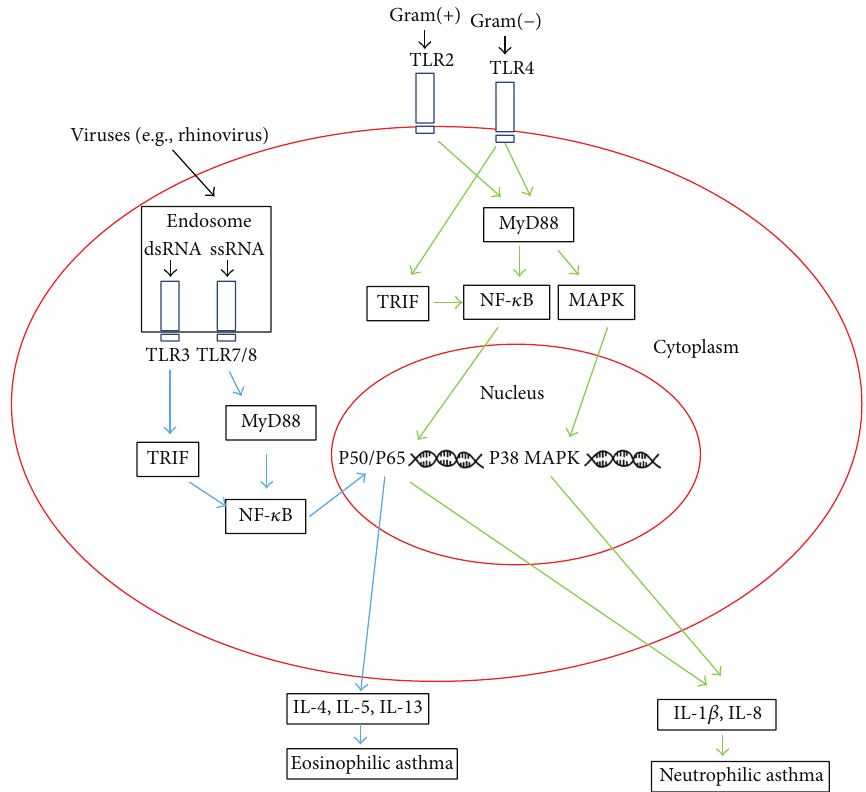
Figure 1: Schematic overview of TLR signaling pathway in neutrophilic and eosinophilic asthma. Gram-negative and Gram-positive bacteria as well as respiratory viruses (e.g., rhinovirus) are detected by TLRs. Subsequently, TLR3 and TLR7/8 trigger TRIF and MyD88 pathways, respectively, followed by the transcription of NF- 𝜅 B in nucleus and the production of IL-4, IL-5, and IL-13, inducing eosinophilic asthma. TLR2 and TLR4 induce MyD88 and MyD88 as well as TRIF cascades, respectively, followed by the transcriptions of MAPK and NF- 𝜅 B into nucleus, triggering the release of IL-1 𝛽 and IL-8 and the onset of neutrophilic asthma. MAPK: mitogen-activated protein kinase; MyD88: myeloid differentiation primary-response gene 88; NF- 𝜅 B: nuclear factor- 𝜅 B; TLR: Toll-like receptor; TRIF: Toll/IL-1R (TIR) domain containing adaptor protein inducing IFN- 𝛽